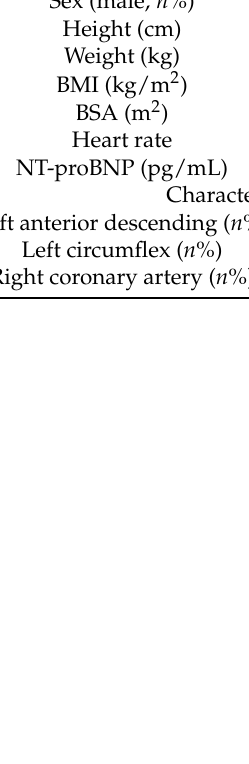
Table 2. LV conventional parameters and infarct